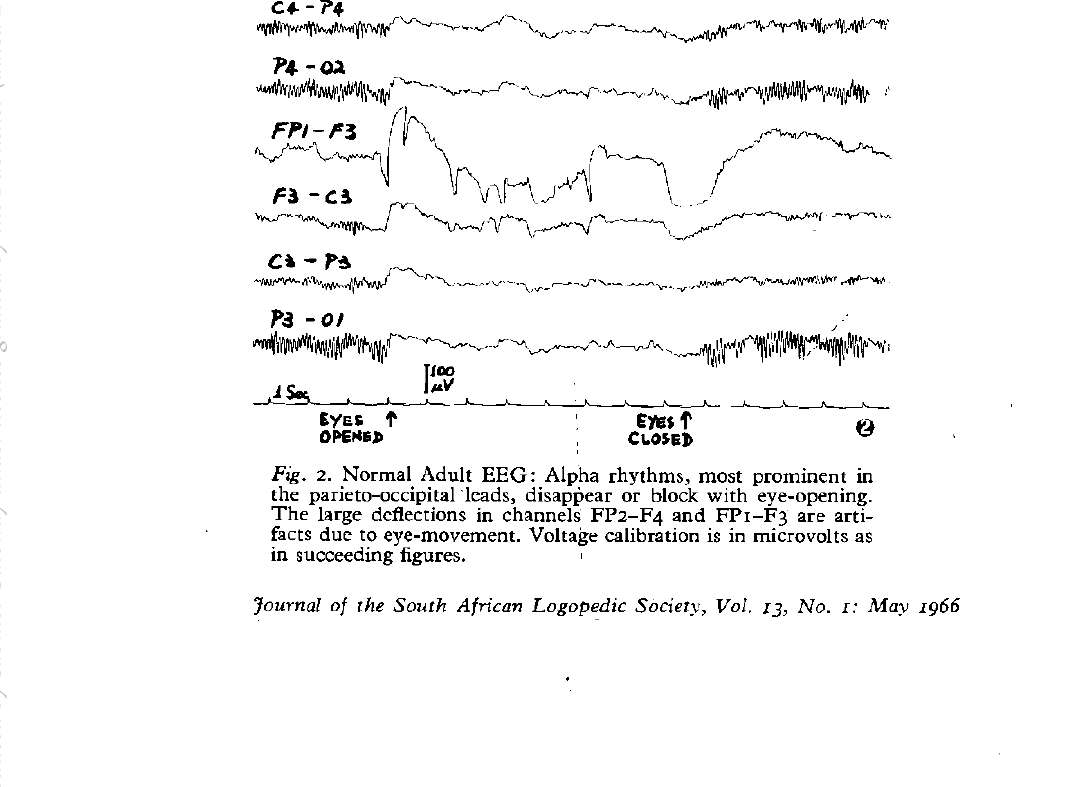
Fig. 2. Normal Adult EEG: Alpha rhythms, most prominent in the parieto-occipital leads, disappear or block with eye-opening. The large deflections in channels FP2-F4 and FP1-F3 are arti- facts due to eye-movement. Voltage calibration is in microvolts as in succeeding